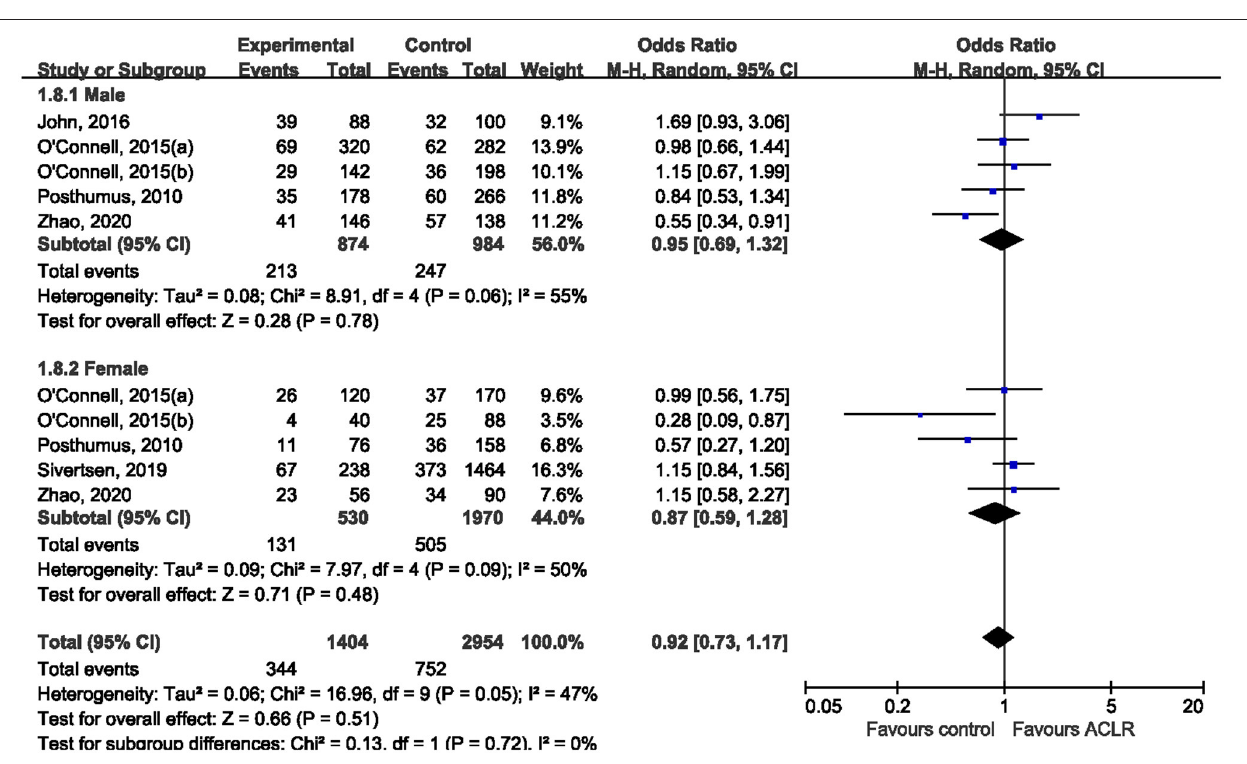
FIGURE 4 | Stratification analyses of sex between rs970547 polymorphism in COL12A1 gene and ACLR risk under the allele model (A vs.